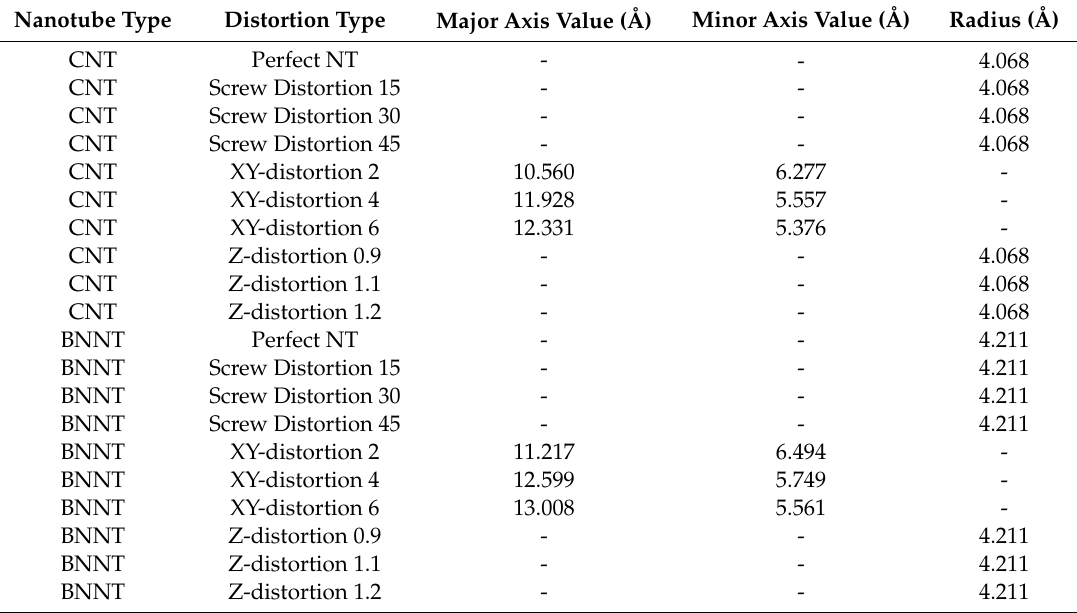
Table 1. Dimensions of different nanotubes used in this study. Z-distortion nanotube (stretch factor: Z’ / Z0), twisted nanotube (screw factor: β / Z0), and XY-distortion nanotube (ellipse factor: e = ∆ X / ∆ Y). Nanotube type